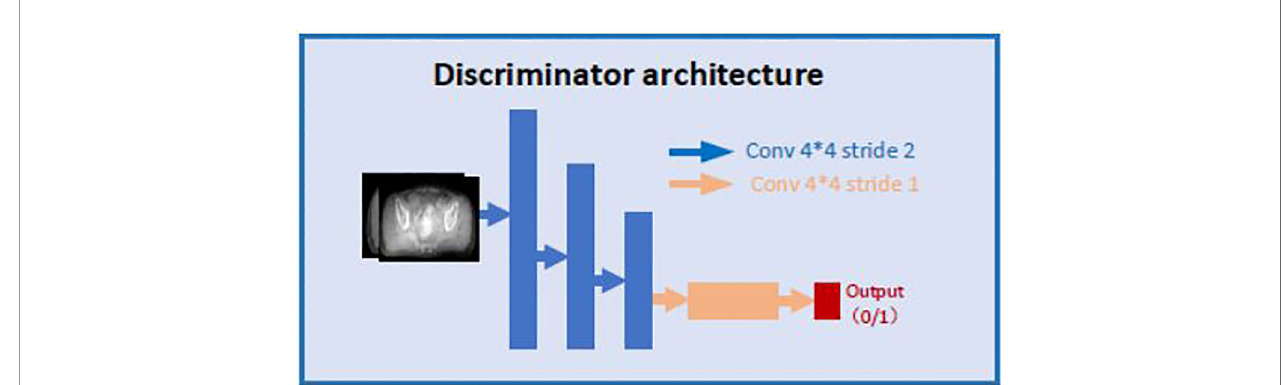
FIGURE 3 | Architecture of the discriminator.